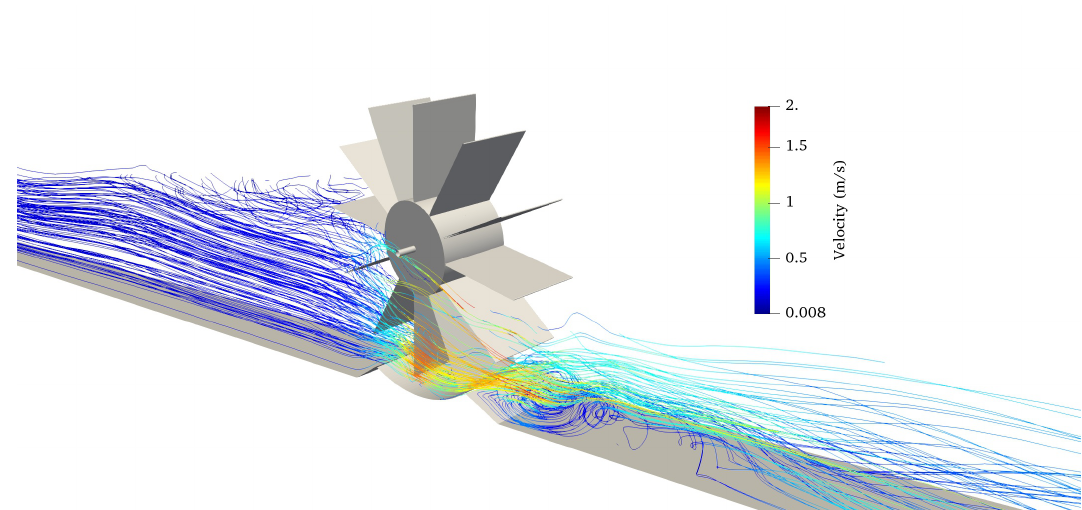
Figure 12. Streamlines of water flow near the HPM, at time t = 4.0